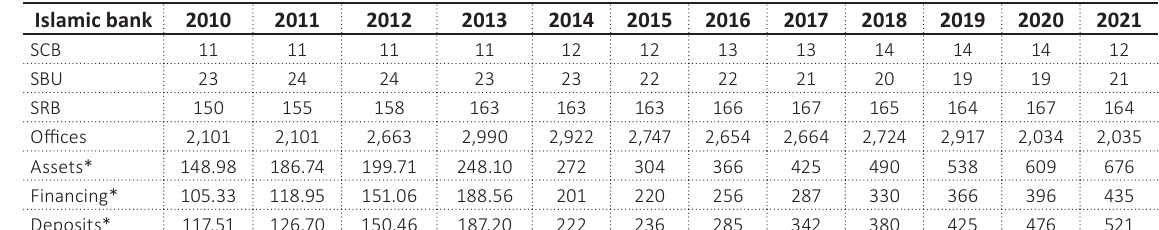
Table 1. Indonesian Islamic Banks (IIB) data and